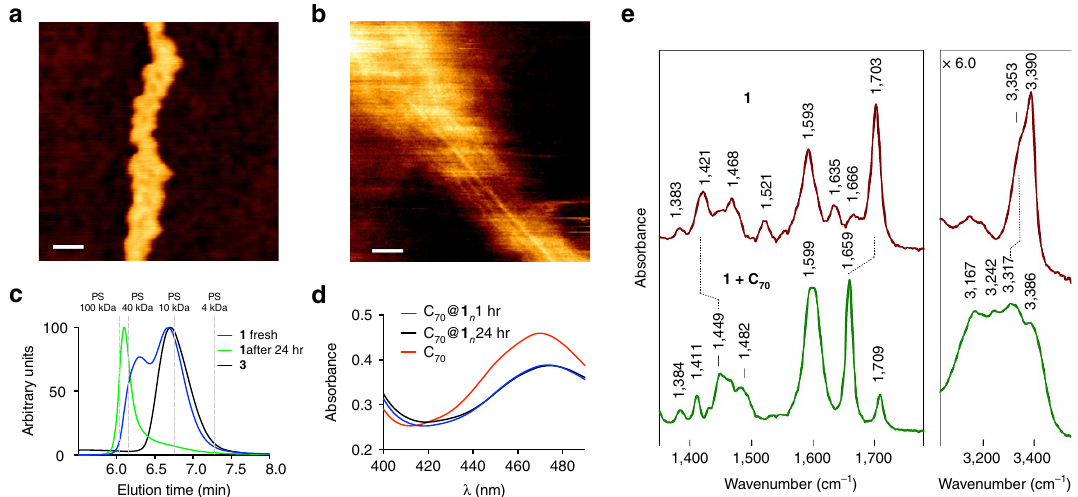
Figure 3 | Characterization of supramolecular tubular polymers. ( a ) AFM image of 1 deposited on silicon surface. ( b ) AFM image of 2 deposited on mica surface. ( c ) Normalized GPC trace of the solution of 1 (fresh and aged) and control compound 3 in toluene. The vertical dashed lines correspond to the retention times of polystyrene (PS) standards. ( d ) Ultraviolet–visible spectra of C 70 and C 70 / 1 1:4 mixture in CDCl 3 . ( e ) Fourier transform infrared spectra of 1 (top) and C 70 / 1 1:4 mixture (bottom) in CDCl 3 . Scale bars, 100nm ( a ) and 100nm ( b